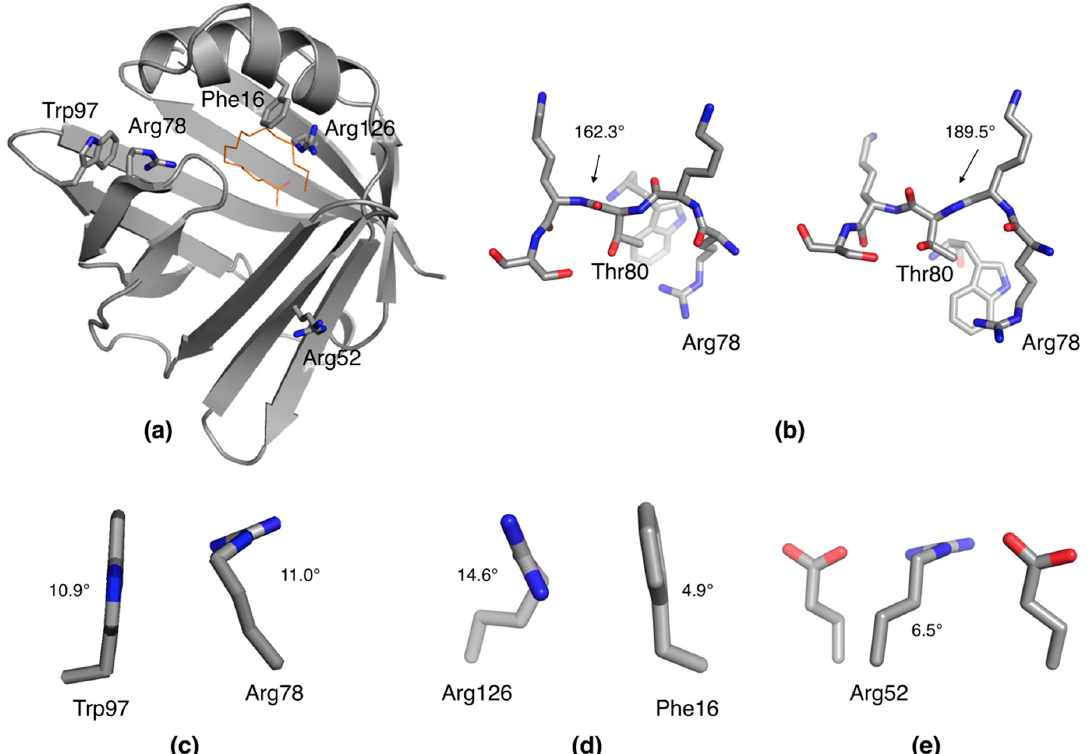
Figure 4. Unconventional conformations are revealed at ultrahigh resolution. ( a ) Location of the distorted side chains in the d-P2 3D structure. Note how Arg78/Trp97 and Phe16/Arg126 are in close contact. ( b ) Peptide bond distortion on both sides of Thr80 leads to its insertion deeper into the structure, interacting with Arg78 and Trp97. The ω angles for the two adjacent bent peptide bonds are shown from two slightly different views. ( c ) Packing of Trp97 against Arg78. Both side chains are strong geometric outliers due to non-planarity. ( d ) Arg126 packs against Phe16, and both residues show loss of planarity in the side chain. ( e ) Arg52 is twisted, apparently to optimize its conformation between two Glu residues.